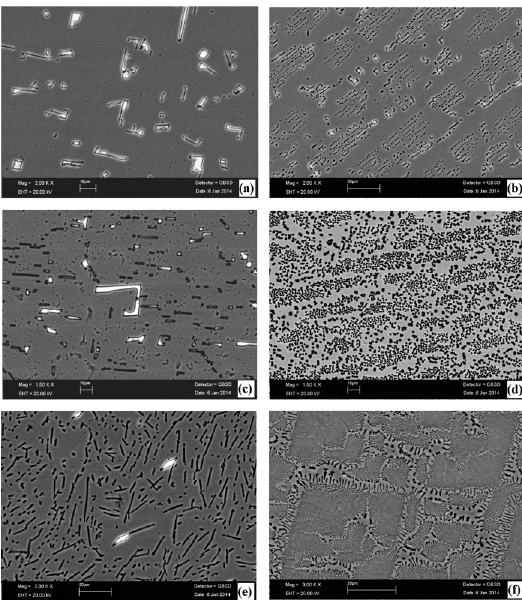
Fig. 6 Rod eutectic microstructures images of directionally solidified Al–1.9Mn–xFe alloys at constant G (6.7 K/mm) (a) Al–1.9Mn–0.5Fe ( V =8.3 μm/s) (b) Al–1.9Mn–0.5Fe ( V =987 μm/s) (c) Al–1.9Mn–1.5Fe ( V =8.3 μm/s) (d) Al–1.9Mn–1.5Fe ( V =978 μm/s) (e) Al–1.9Mn–5Fe ( V =8.3 μm/s) (b) Al–1.9Mn–5Fe ( V =978 μm/s)